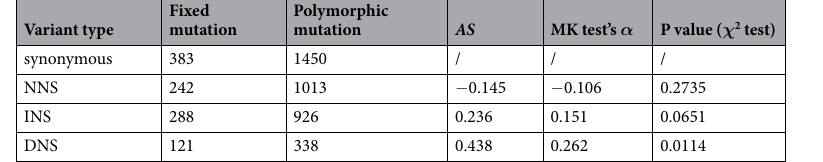
Table 1. MK test and AS , α statistic of different categories of